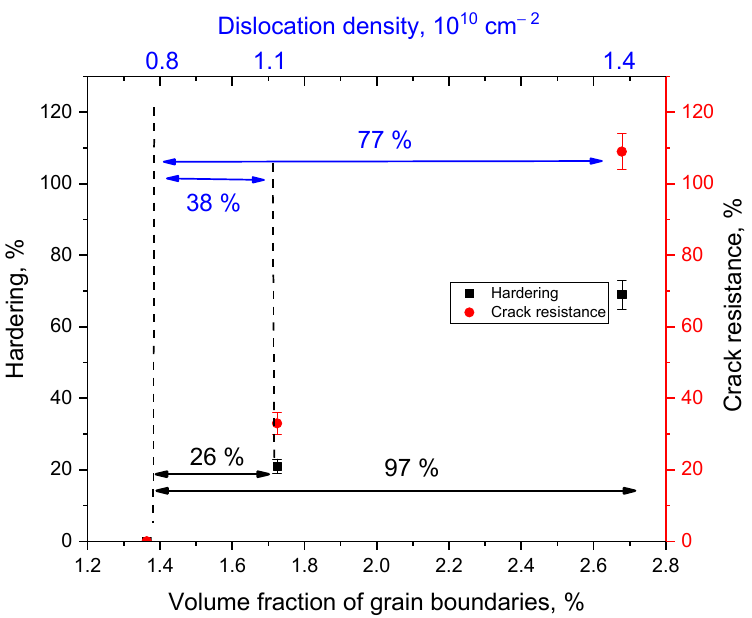
Figure 4. Evaluation of the contributions of changes in the dislocation density and volume fraction of grain boundaries in ceramics to the effects of hardening and increase in crack resistance.